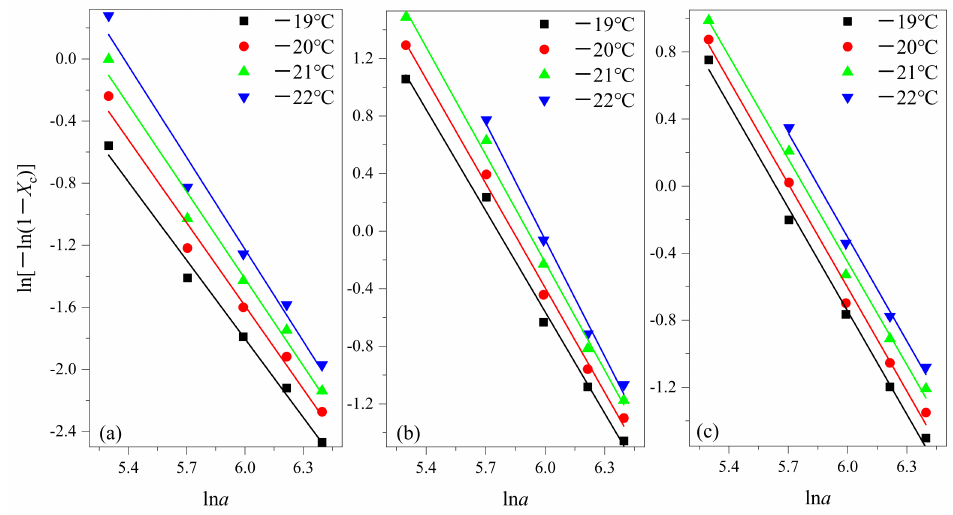
Figure 3. Plots of ln[ − ln(1 − X c )] versus ln a for non-isothermal crystallization of ( a ) PEG in method 1, ( b ) PEG-PLLA in method 1 and ( c ) PEG-PLLA in method 2. Table 2. The non-isothermal crystallization kinetics parameters based on the Ozawa method for (a)